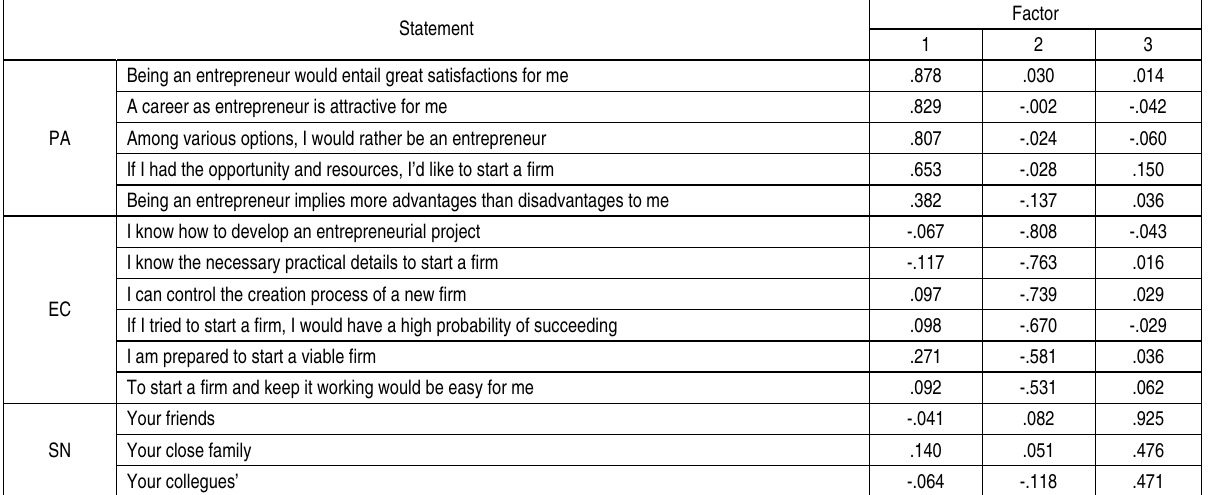
Table 3. Pattern matrix